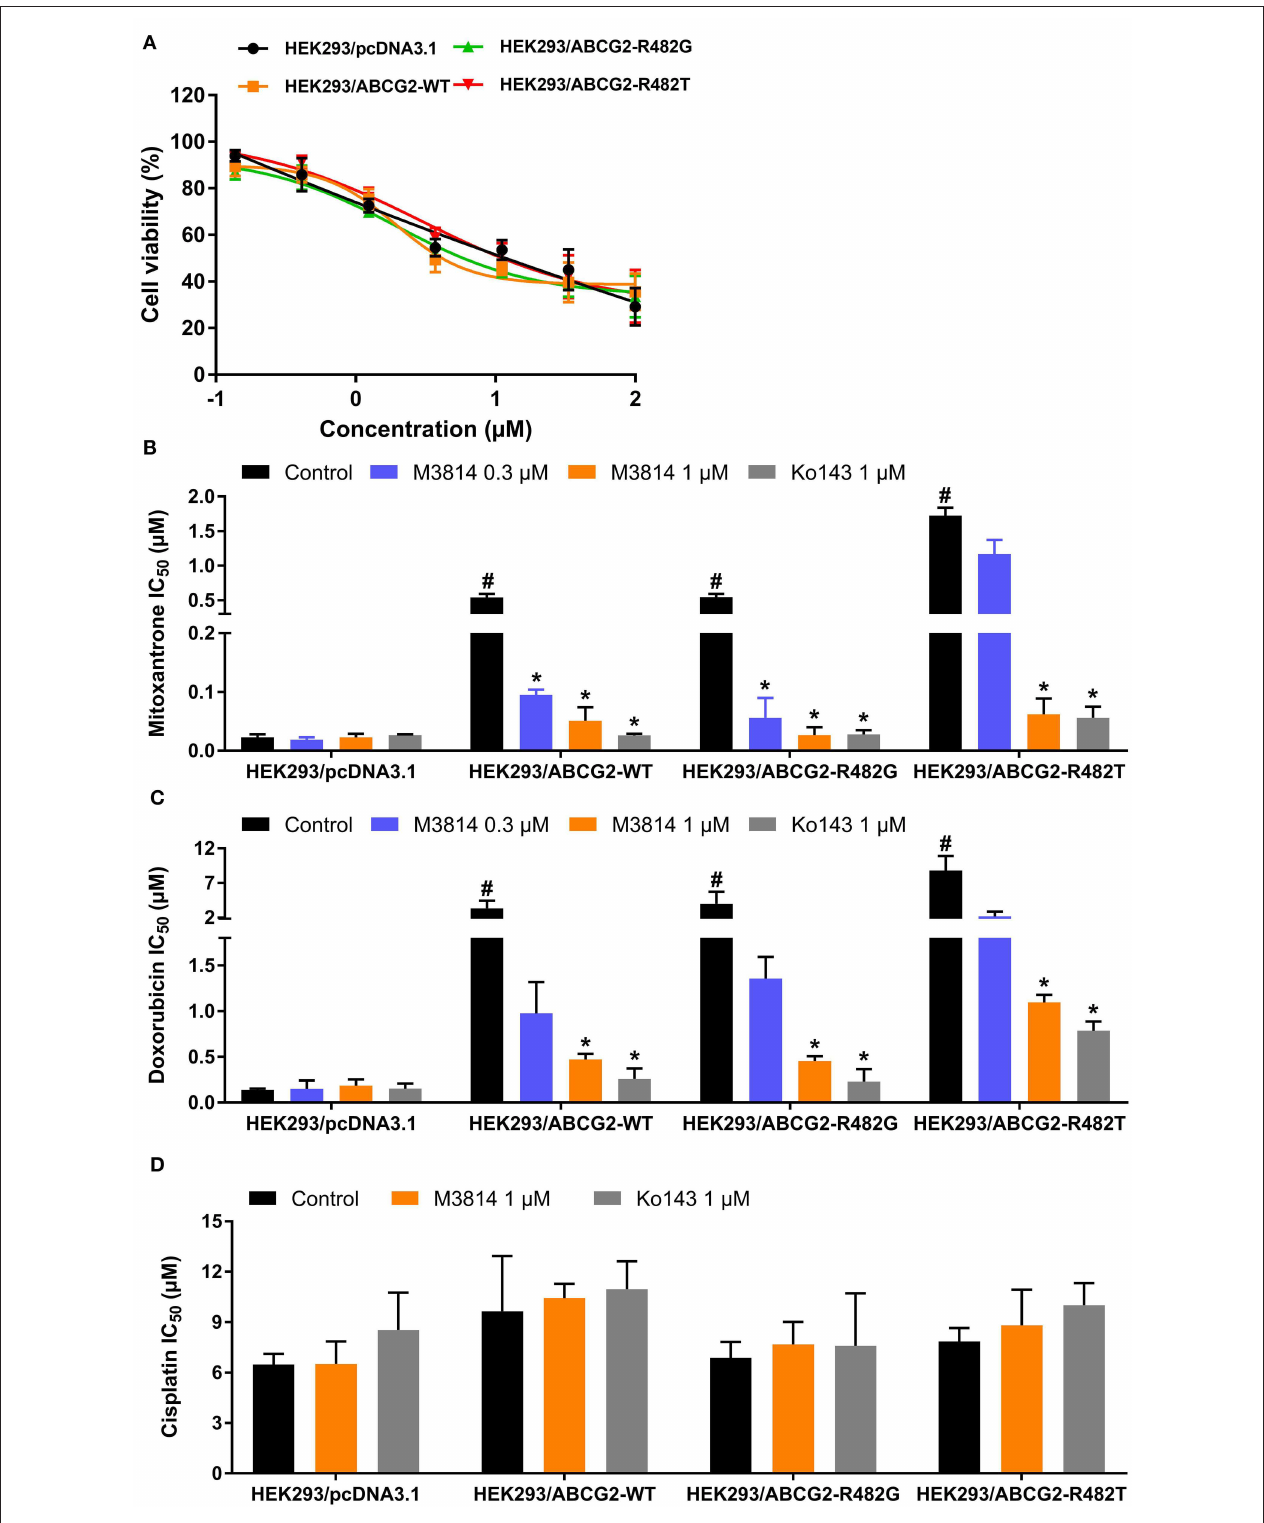
FIGURE 2 | The effect of M3814 on the cytotoxicity of different anticancer drugs in ABCG2-overexpressing HEK293 transfected cells. (A) Cell viability curves for HEK293/pcDNA3.1, HEK293/ABCG2-WT, HEK293/ABCG2-R482G, and HEK293/ABCG2-R482T cells; The effect of M3814 on the cytotoxicity of mitoxantrone (B) , doxorubicin (C) , and cisplatin (D) . Data are expressed as mean ± SD from representative of three independent experiments. * p < 0.05 vs. the control group, # p < 0.05 vs. the control group in parental cell lines.